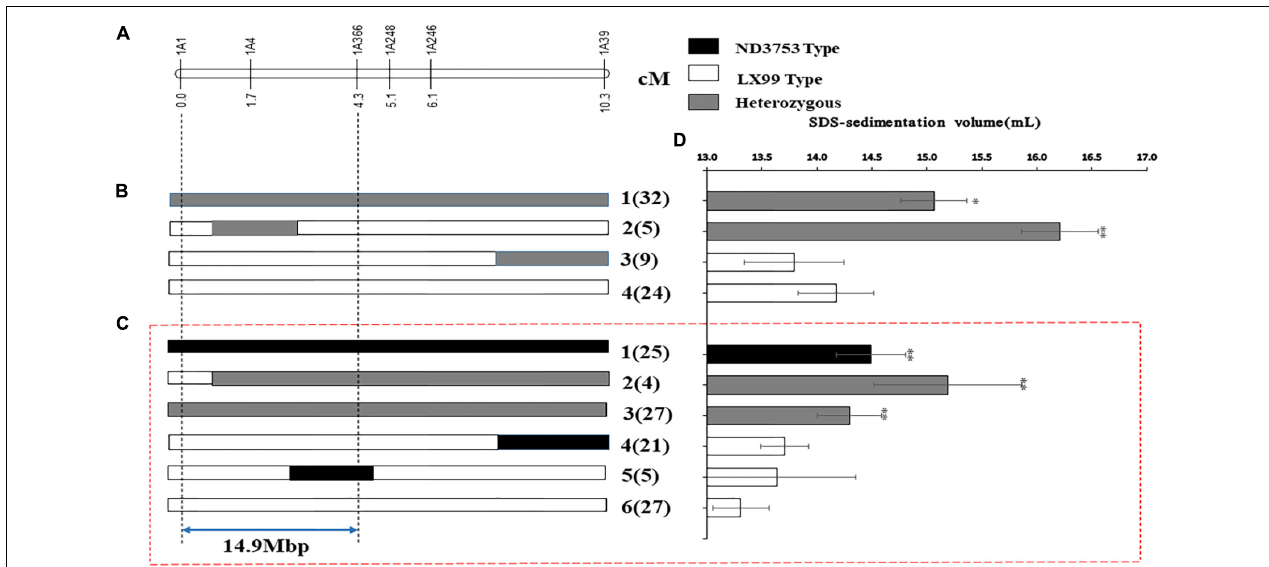
FIGURE 4 | Mapping of QSsv-cau-1A.1.1. (A) Genetic location of the region of interest on chromosome arm 1AL. Graphical illustration of recombinant genotypes from (B) the BC 3 F 1 population and (C) the BC 3 F 2 population in the LX99 background. (D) SSV values (mean ± SD). Black, gray, and white bars represent the ND3753 genotype, heterozygous genotype, and the LX99 genotype, respectively. The arrow indicates the 14.9-Mb mapping interval. Significant differences by comparing with the ND3753 genotype are indicated by * ( p < 0.05), and ** ( p < 0.05) (Student’s t -test). The numbers in and outside the parentheses indicate sample size and recombinant types,